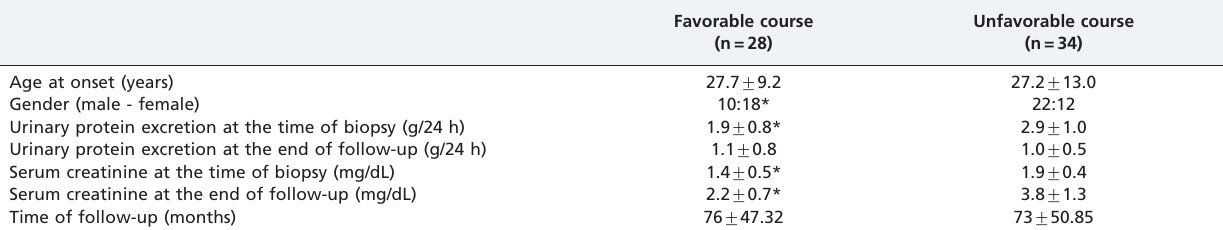
Table 1 - Clinical parameters of IgAN patients with favorable vs. unfavorable clinical disease